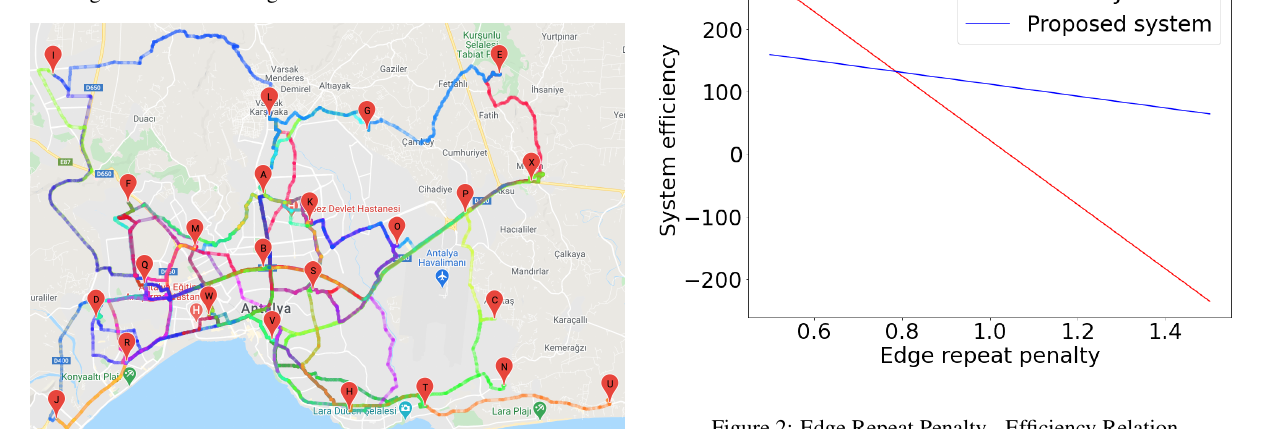
Figure 2: Edge Repeat Penalty - Efficiency